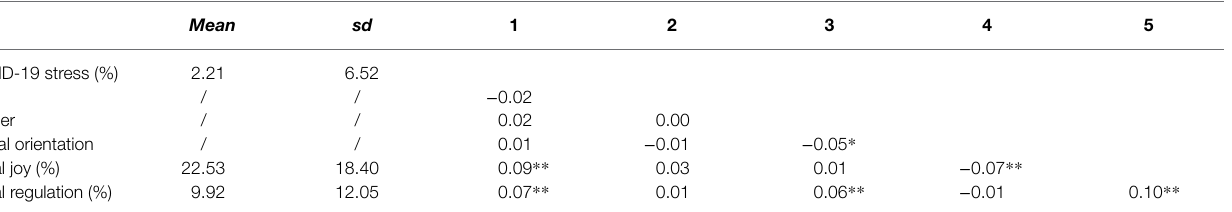
TABLE 2 | Spearman’s rank correlations